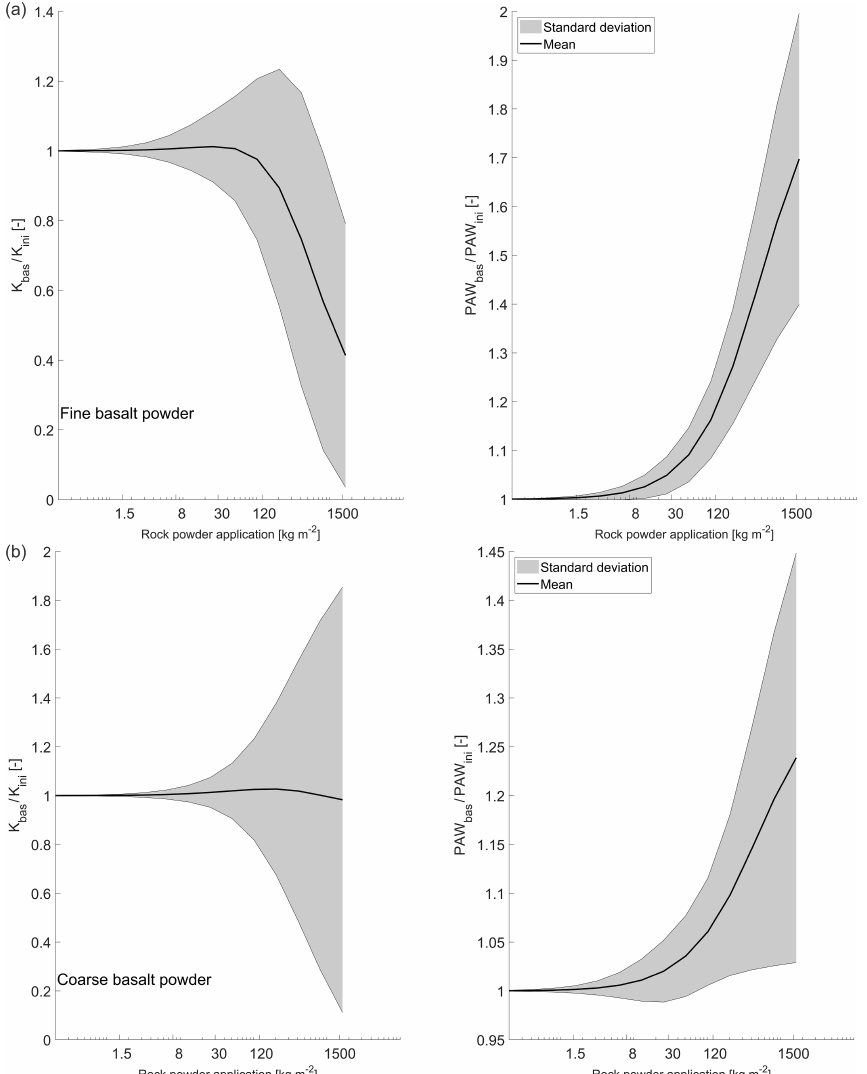
Figure 11. Relative impacts on soil saturated hydraulic conductivity ( K S ) and plant-available water (PAW). K bas and PAW bas , respectively, represent the estimated soil K S and PAW after basalt application. K ini is the estimated initial soil K S , and PAW ini is the estimated initial PAW of different soils. (a) Application of a fine basalt texture (15.6% clay, 83.8% silt, and 0.6% fine sand). (b) Application of a coarse basalt texture (15.6% clay, 53.8% silt, and 30.6% fine sand) for areas corresponding to P budget scenario two, for the N-unlimited AR scenario (Fig. S7c). Mean and standard deviations for n = 2525 grid